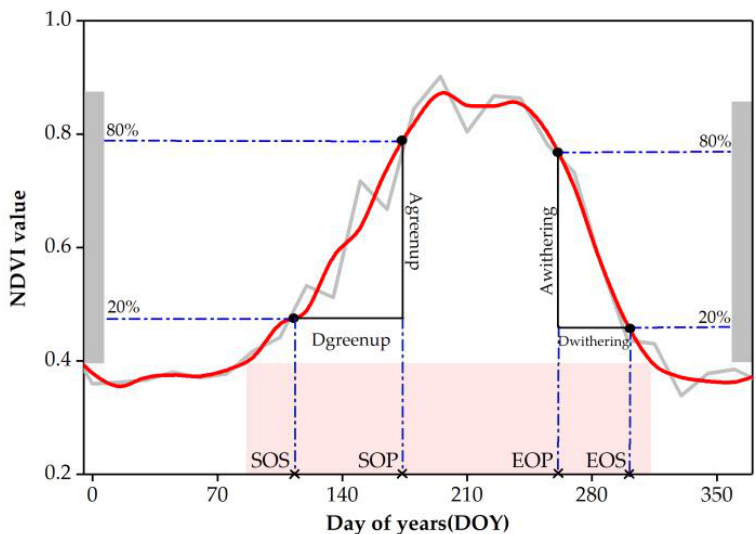
Figure 2. Calculation of vegetation greenup velocity and withering velocity; grey lines represent the annual vegetation growth curve and the red curve is the line of best fit using the S–G filter; the gray strips on the left and right represent the amplitude of NDVI during vegetation greenup and withering, respectively, the prink strips represent base